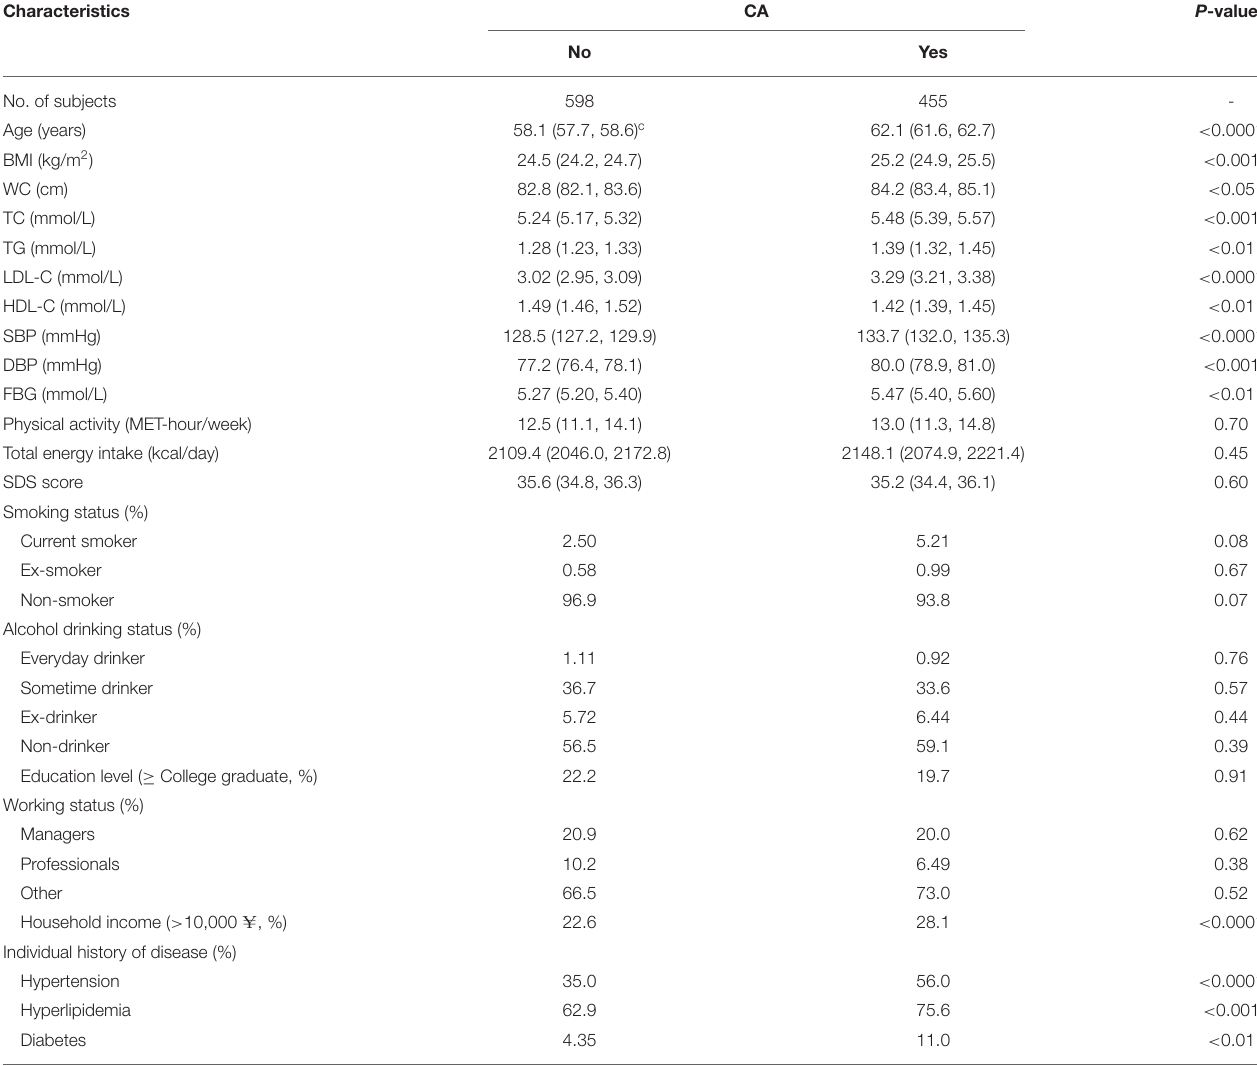
TABLE 2 | Age-adjusted baseline characteristics of study participants by the prevalence of CA in women ( n = 1,053) a . Characteristics